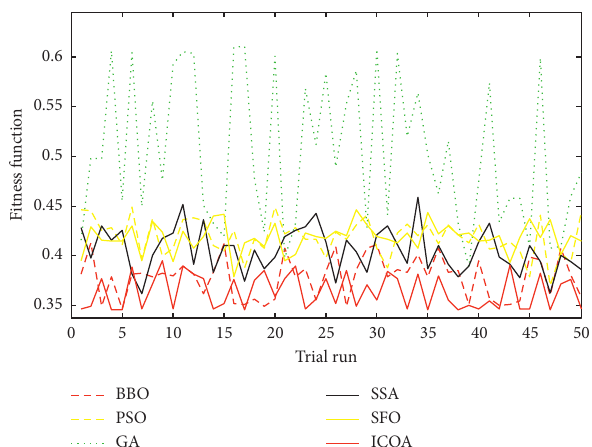
Figure 5: The fitness values of six methods in 50 trial times for the first